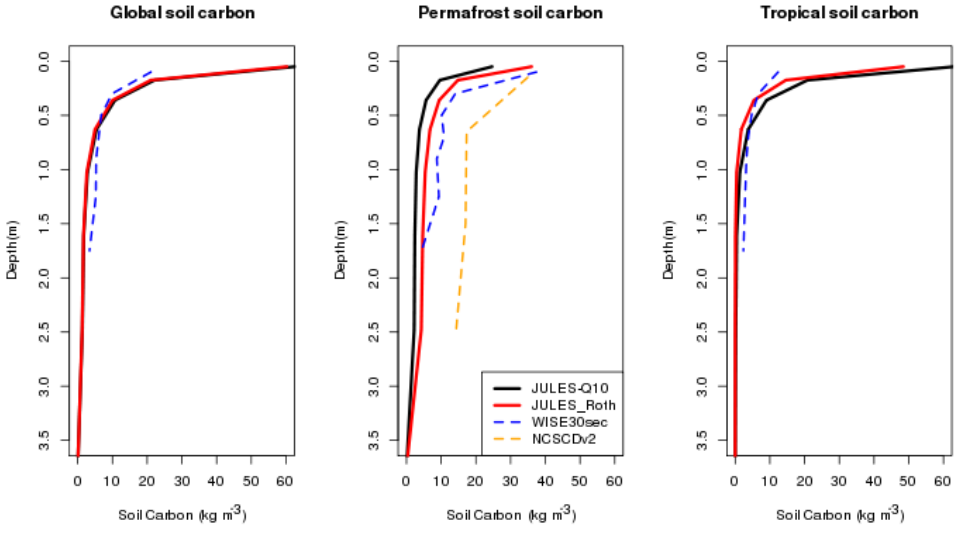
Figure 7. Profile of soil carbon in kgm − 3 for the three main regions in this